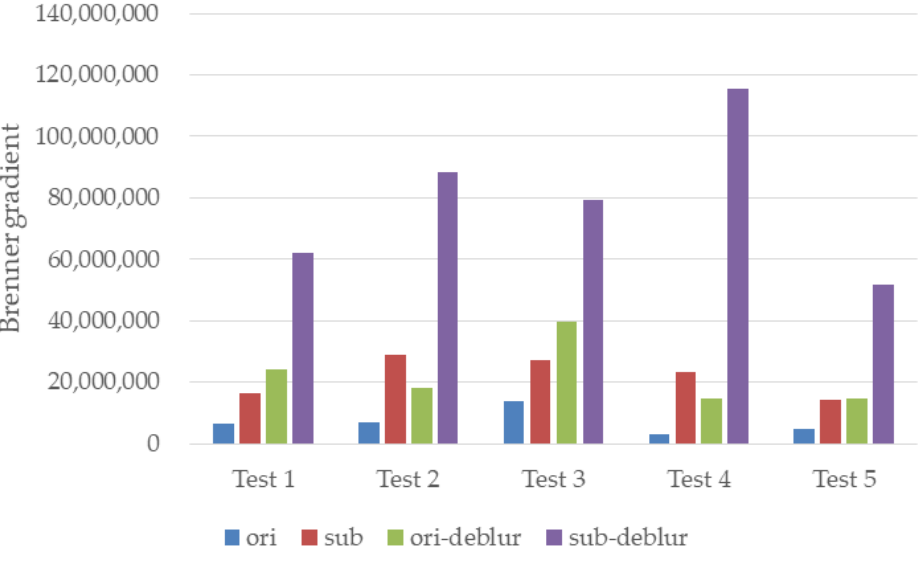
Figure 9. Comparison of images from Figure 8 by the Brenner gradient.